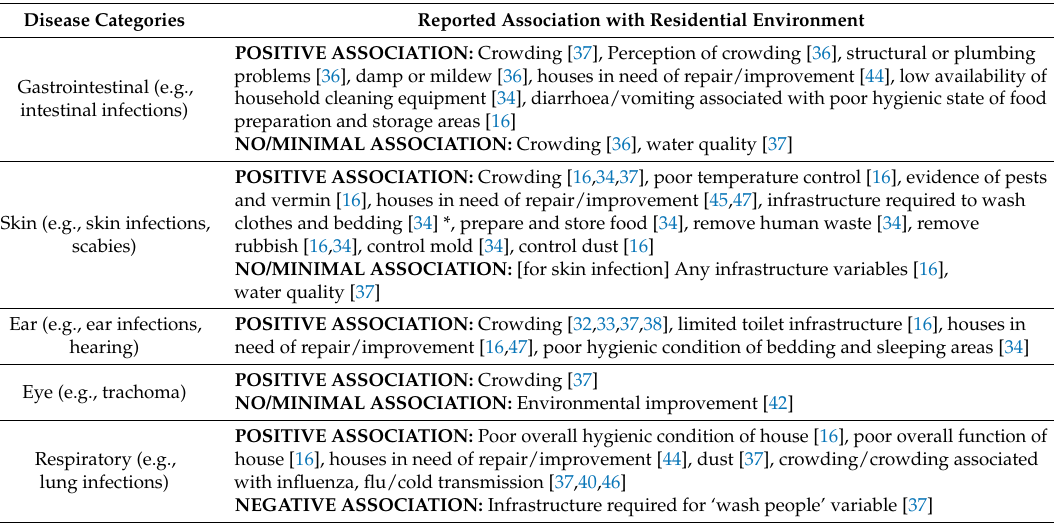
Table 2. Summary of link between infectious diseases and residential